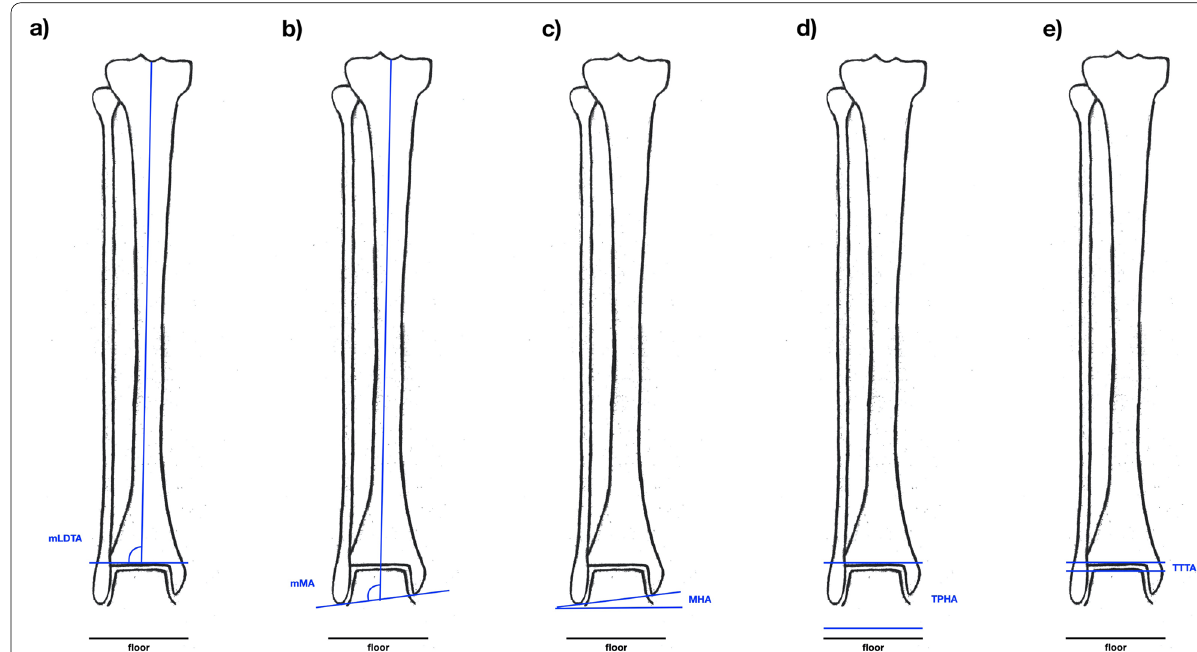
Fig. 4 Illustration of the radiographic parameters measured on a long‑leg standing X‑ray with the knees pointing forward. Measures around the ankle. a mLDTA: angle between tibiaplafond and mechanical tibia axis. b mMA: angle between malleolar tips and mechanical tibia axis. c MHA: angle between malleolar tips and floor. d TPHA: angle between tibiaplafond and floor. e TTTA: angle between tibio‑talar joint surfaces . mLDTA: Mechanical lateral distal tibia angle, mMA: Mechanical Malleolar Angle, MHA: Malleolar Horizontal Orientation Angle, TPHA: Tibia Plafond Horizontal Orientation Angle, TTTA: Tibio Talar Tilt Angle